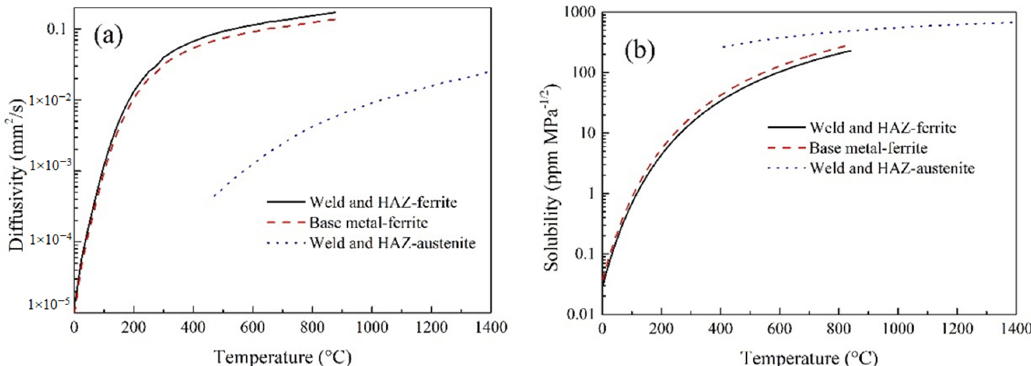
Figure 4. Parameters of hydrogen diffusivity in different phases: ( a ) Hydrogen diffusion coefficient; ( b ) Solubility [33].